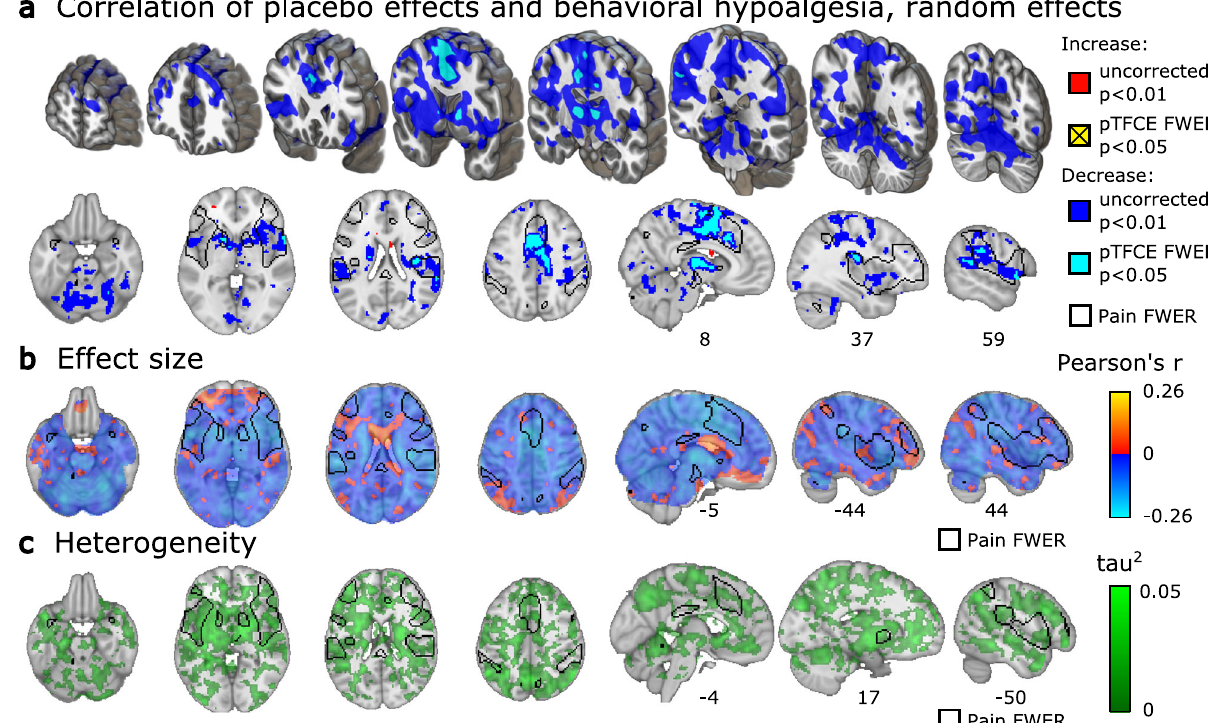
Fig. 3 Correlations of behavioral placebo analgesia and changes in pain-related brain activity. a Whole-brain areas of statistically signi fi cant correlation (Pearson ’ s r ) between behavioral placebo analgesia (pain control − pain placebo ) and placebo-related activity changes (pain placebo − pain control ), thresholded according to z- tests (uncorrected for multiple comparisons, two-sided p < 0.01, red and blue), and thresholded according to pTFCE-enhanced permutation test (controlled for FWER, two-sided p < 0.05, light blue, increased correlations did not reach corrected statistical signi fi cance); b unthresholded Pearson ’ s r , range: [ − 0.26; 0.17]; c between-study heterogeneity τ (range: [0, 0.32]) for the same relationship (permutation test controlled for FWER, one-sided p < 0.05, indicated no statistically signi fi cant voxels); τ is plotted as τ 2 to emphasize regions of high heterogeneity. all: n = 384 – 460 individuals from 15 to 18 independent studies per voxel. a , b , and c are shown with a contour of FWER-corrected permutation test results for pain > baseline, as shown in Fig. 1a. Correlations were computed across individual participants in the full sample, excluding between-group studies (where individual estimates of behavioral placebo analgesia are not possible). On panels a and b , red-yellow and blue-light blue shades denote increased and decreased activity associated with larger placebo analgesia, respectively. Three-dimensional coronal slices are equidistantly distributed from y = 60 to − 68 mm. Axial slices range equidistantly from z = − 22 to 42 mm. Custom coordinates for sagittal slices are displayed in mm. Source data (results as 3d-volumes) are provided at